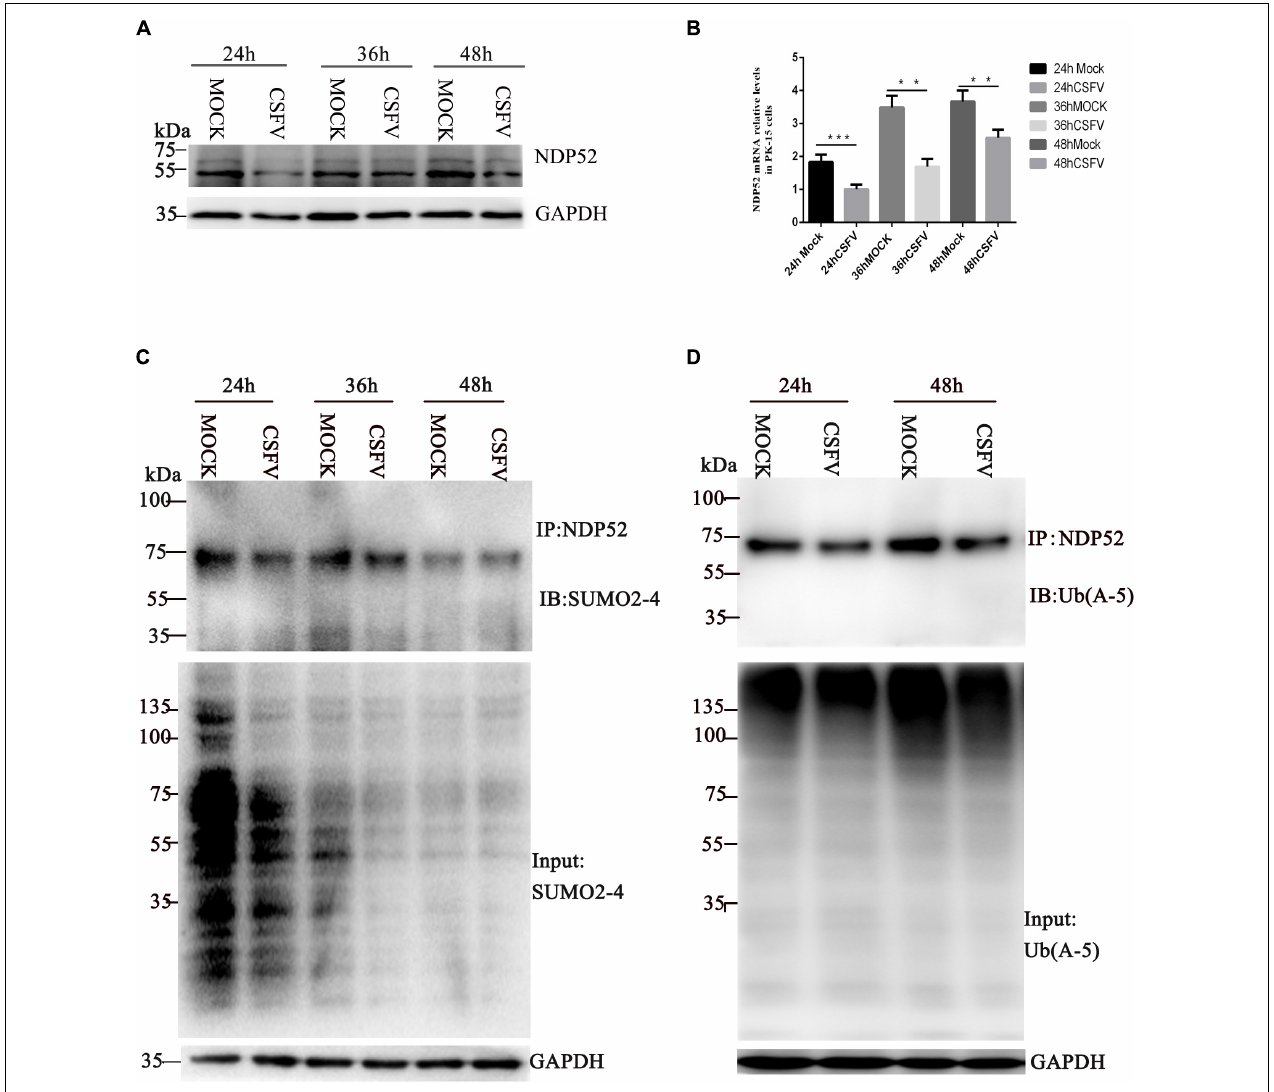
FIGURE 1 | Classical swine fever virus (CSFV) inhibits NDP52 (CALCOCO2) ubiquitination and SUMOylation. (A) PK-15 cells were infected with CSFV (MOI = 0.1) or un-infected (MOCK) at the indicated time points. CALCOCO2, N pro , and GAPDH levels were analyzed by Western blot. (B) After CSFV infection, CALCOCO2 mRNA was detected by qRT-PCR. The data represent the mean ± SD of three independent experiments. Data were tested by one-way ANOVA with Fisher’s least significant difference (LSD) post hoc correction. ∗ P < 0.05; ∗∗ P < 0.01; ∗∗∗ P < 0.001; # P > 0.05. (C) PK-15 cells were infected with CSFV. NDP52 SUMOylation was analyzed by immunoblot using anti-SUMO2-4 antibody. SUMO2-4 expression in CSFV-infected cells was used as the input control. (D) Ubiquitinated NDP52 was immunoblotted with anti-Ub(A-5) antibody. Ub(A-5) expression in CSFV-infected cells was used as the input control. GAPDH was used as the internal loading